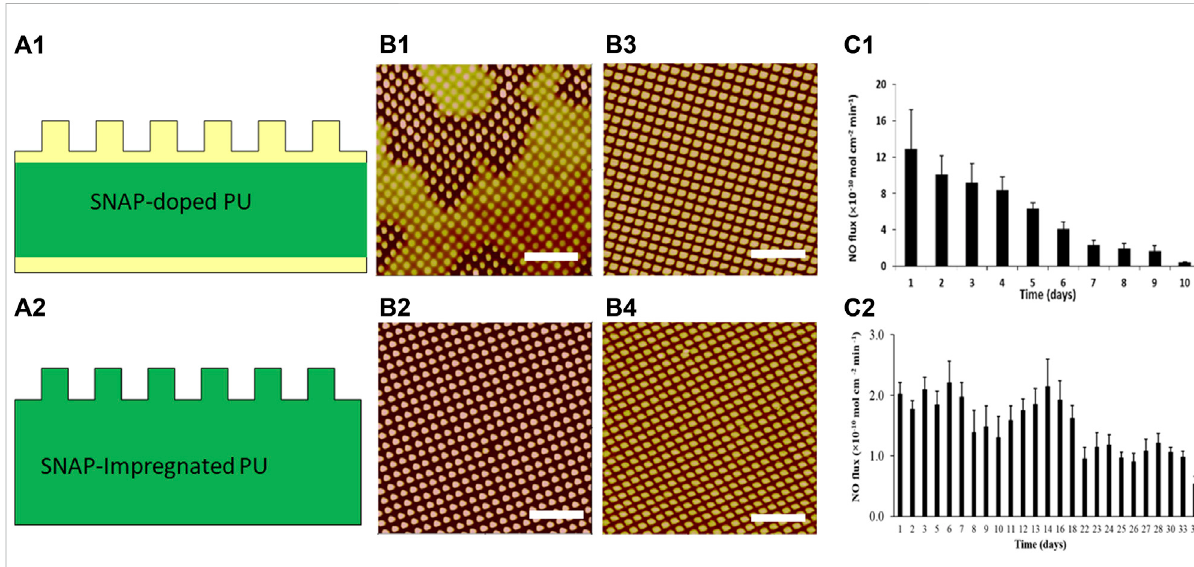
FIGURE 5 Schematic diagrams of textured and NO-releasing biomaterials by SNAP-doped (A1) and SNAP-impregnated (A2) PU fi lms. Yellow color representsregularPUandgreencolorrepresentsSNAPcontainingPU.AFMtopographicimagesofthinSNAP-dopedPU (B1) andthickSNAP-doped PU (B2) with pattern 500/500/600 nm, textured PUs with pattern 700/700/300 nm before (B3) and after (B4) impregnated with SNAP; NO release fromSNAP-dopedPU (C1) andSNAP-impregnatedPU (C2) .Scalebar=5 µm.ReprintedfromXuLCetal. ActaBiomaterialia,2017.51:p.53 – 65 and Wo Y et al. Biomaterials Science, 2017. 5(7): p. 1265 –